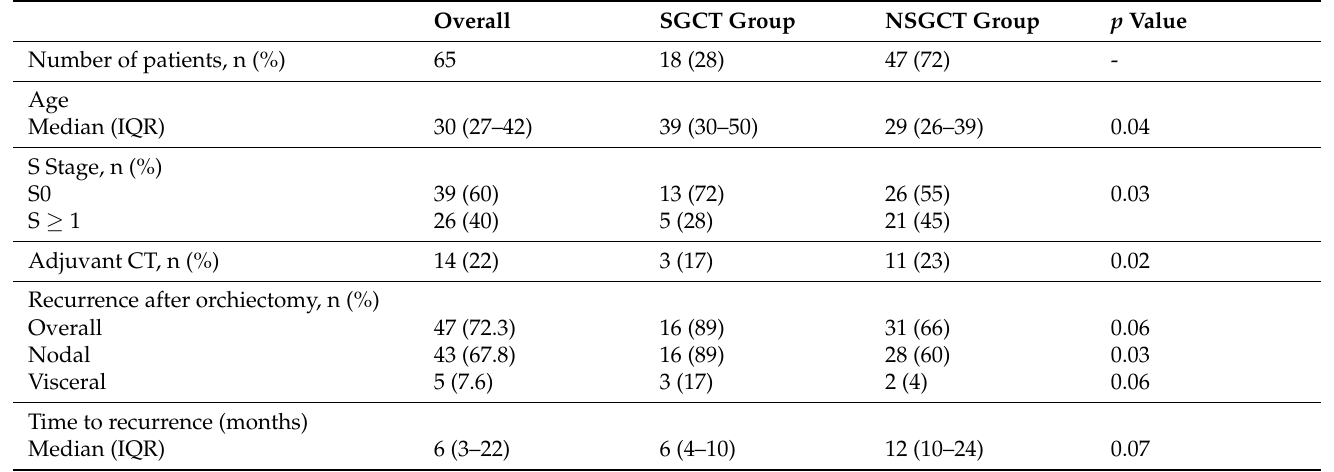
Table 2. Clinical and pathological characteristics of the study population among seminomatous and non-seminomatous groups prior to